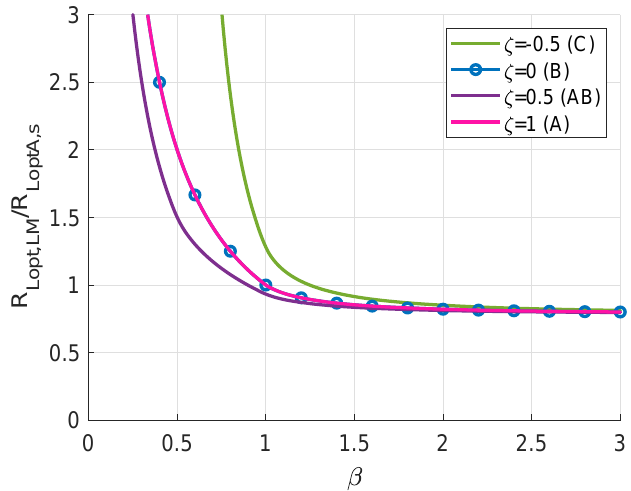
Figure 13. Load modulation as a function of β .